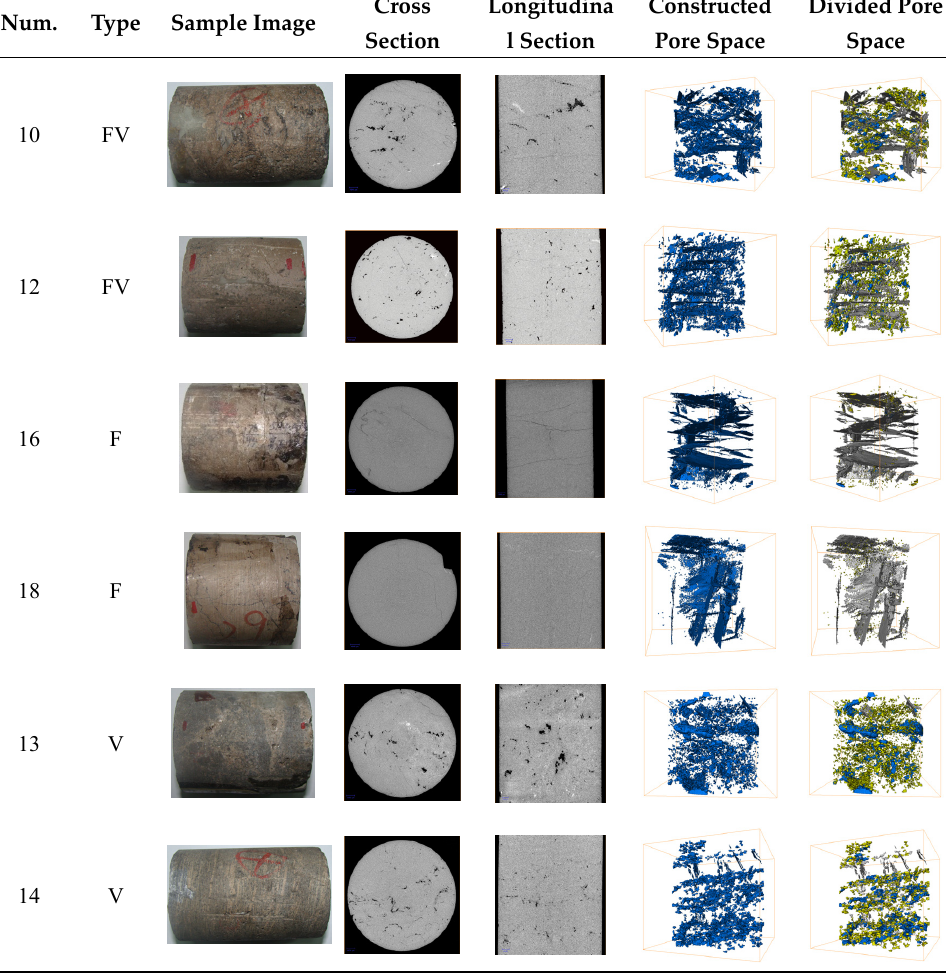
Figure 8. Examples of the sample, cross section, and longitudinal section of the CT scanning image, constructed pore space, and divided pore space of the carbonate samples. ‘FV’, ‘F’, and ‘V’ represent fractured-vuggy carbonate, fractured carbonate, and vuggy carbonate, respectively. The total pore spaces of the carbonate samples are in blue as shown in the sixth column. The pore space after division is shown in the seventh column with the fractures colored in gray, vugs in blue, and pores in yellow. The rest of the constructed and divided pore spaces of the samples are provided in the supplementary file. The subgraphs are too small that a scale would be hard to see if it is directly marked on the subgraph. Thus, instead of a scale, we provide the physical size including the radius and the length of all the samples in Table 1.